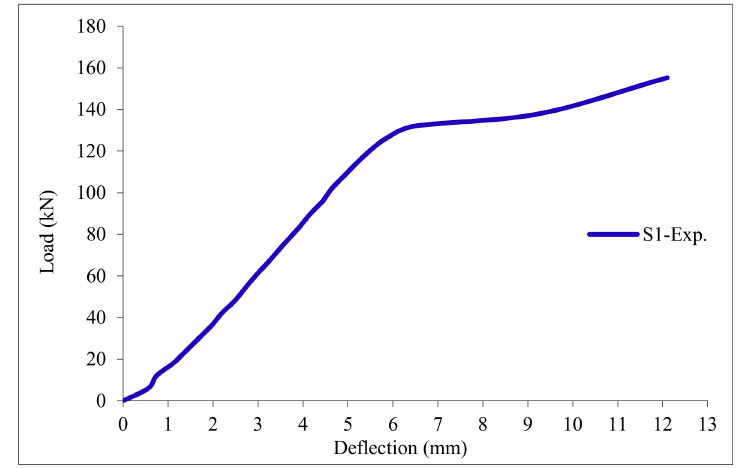
Figure 17. Load deflection curve for control slab S1.